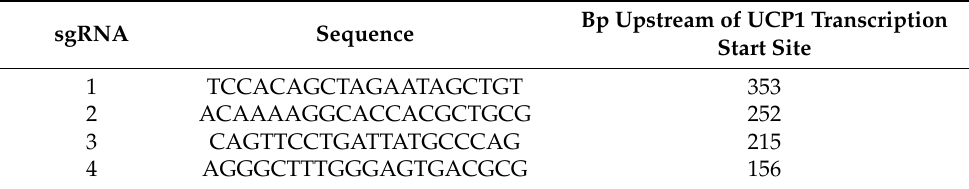
Table 1. sgRNAa targeting mus musculus UCP1